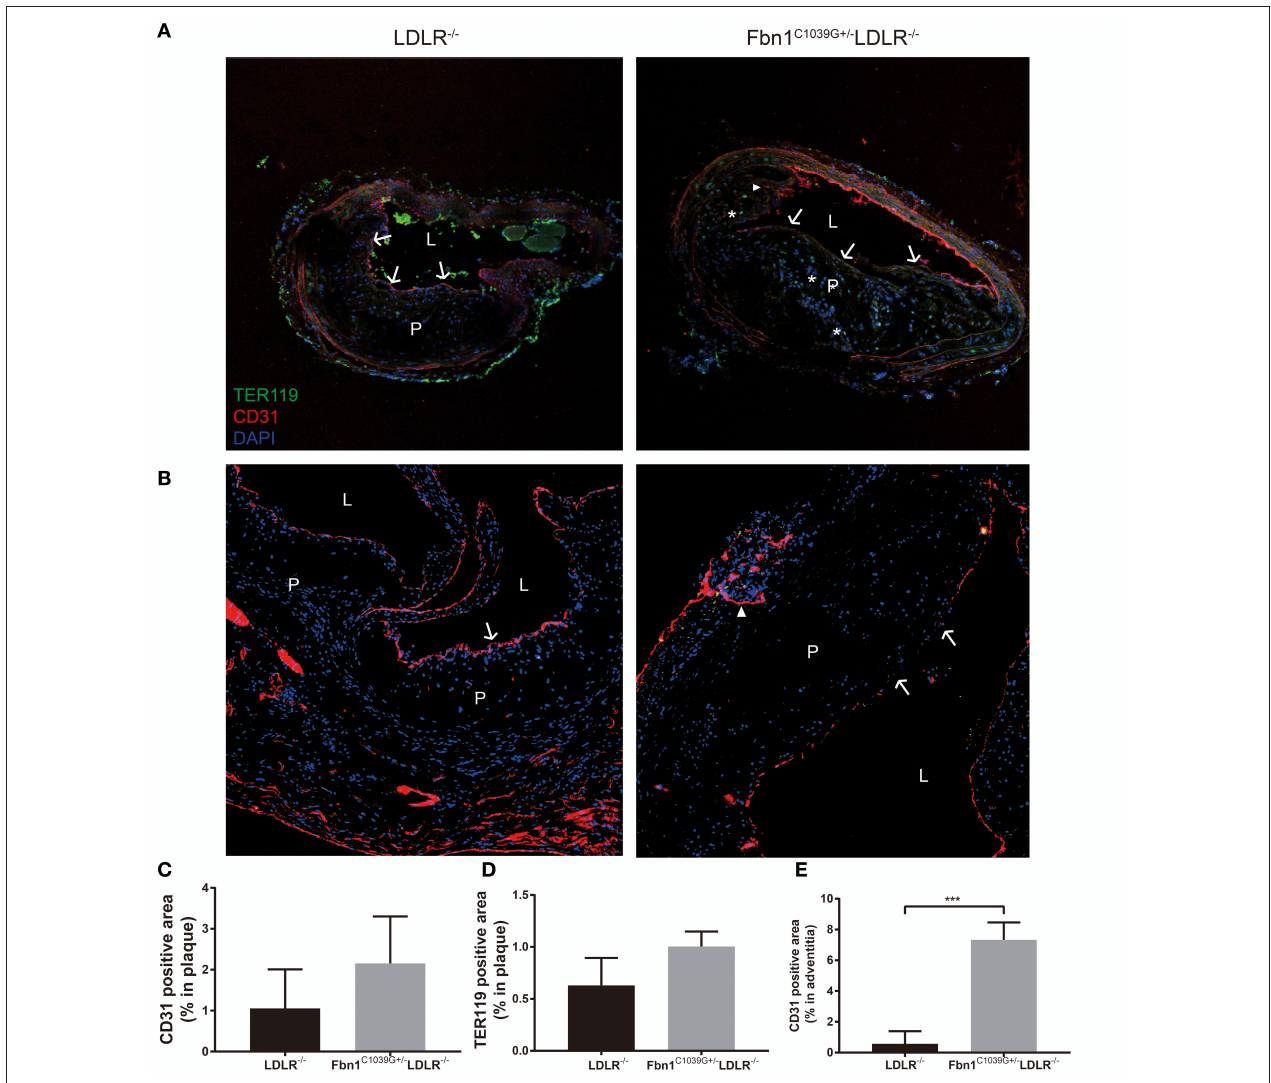
FIGURE 6 | Damaged endothelium, intraplaque hemorrhage and neovascularization. (A) Immunofluorescence staining of the brachial artery in Fbn1 C1039G + / − LDLR − / − mice and LDLR − / − mice after 24 weeks on a HFD. (B) Immunofluorescence staining of the aortic sinus in Fbn1 C1039G + / − LDLR − / − mice and LDLR − / − mice after 24 weeks on a HFD. (C) Immunofluorescence staining quantification of the CD31-positive area (% of plaque) in Fbn1 C1039G + / − LDLR − / − mice and LDLR − / − mice after 24 weeks on a HFD. (D) Immunofluorescence staining statistics of the TER119-positive area (% of plaque) in Fbn1 C1039G + / − LDLR − / − mice and LDLR − / − mice after 24 weeks on a HFD. (E) Quantification of the CD31-positive area (% of media and adventitia) in Fbn1 C1039G + / − LDLR − / − mice and LDLR − / − mice after 24 weeks on a HFD ( n = 5 in Fbn1 C1039G + / − LDLR − / − mice, n = 3 in LDLR − / − mice), *** p < 0.001. Magnification: × 100. TER119 shows red blood cells, CD31 shows endothelial cells, and DAPI shows nuclei. The arrow indicates the endothelial barrier, the triangle indicates neovascularization, and *indicates intraplaque hemorrhage. P, plaque; L,